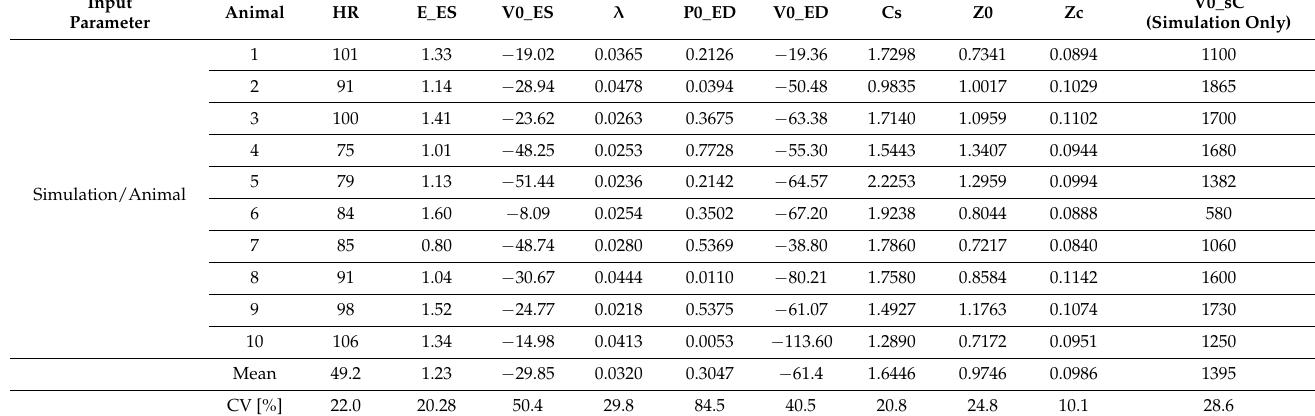
Table 1. Parameters derived from the animal studies, which were used to parametrize the sim- ulation model: HR: heartrate [bpm], E_ES: slope of the ESPVR [mmHg/mL], V0_ES: unstressed volume of the ESPVR [mL], λ : coefficient of the exponential EDPVR, P0_ED: coefficient of the ex- ponential EDPVR [mmHg], V0_ED: unstressed volume of the EDPVR [mL], Cs: systemic arterial compliance [mmHg/mL], Z0: systemic arterial resistance [mmHg*s/mL], Zc: specific aortal resis- tance [mmHg*s/mL], V0_sC: unstressed volume of the systemic venous compliance [mL], and CV: coefficient of variation [%].